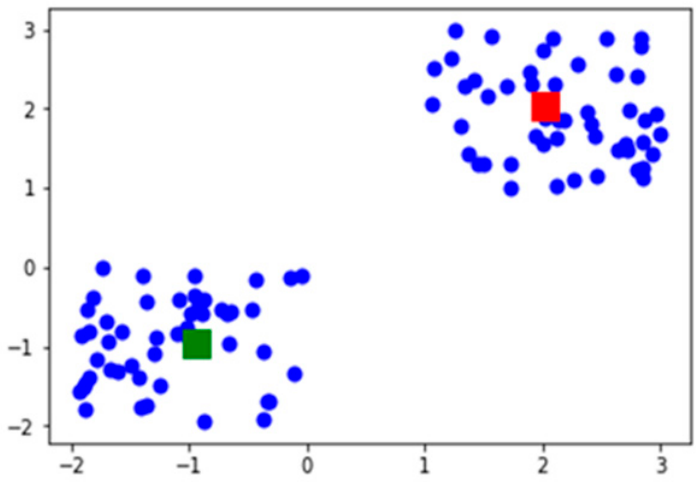
Figure 5. Centroids of the cluster .